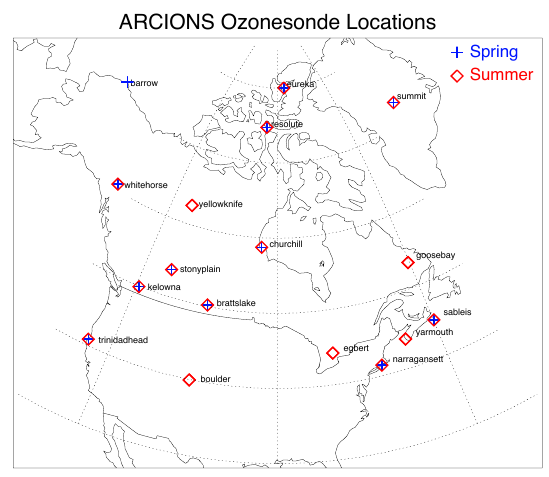
Figure 8. Location of ARCIONS ozonesonde sites used in April and June–July 2008 in coordination with